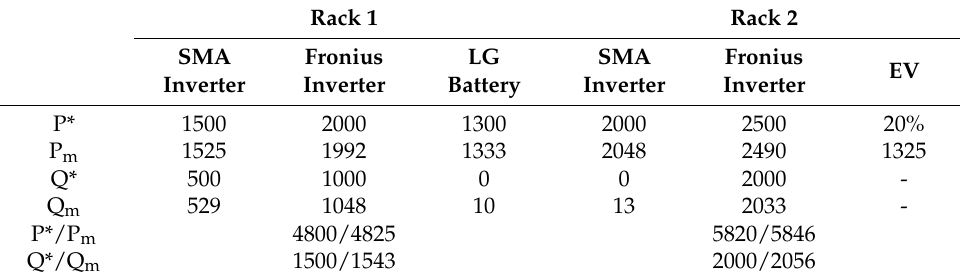
Table 3. Sample PHIL Test